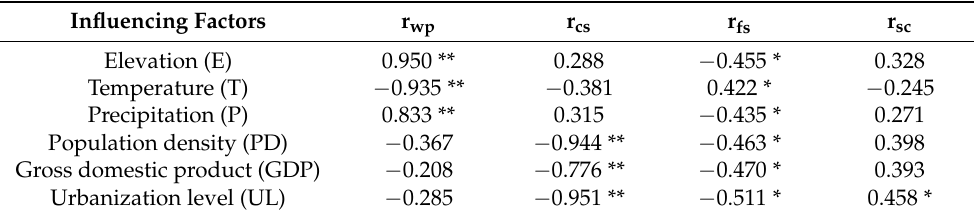
Table 4. Analysis results of the correlation between the supply-demand ratio of ESs and influenc- ing factors. Influencing Factors r wp r cs r fs r sc Elevation (E) 0.950 ** 0.288 − 0.455 * Temperature (T) − 0.935